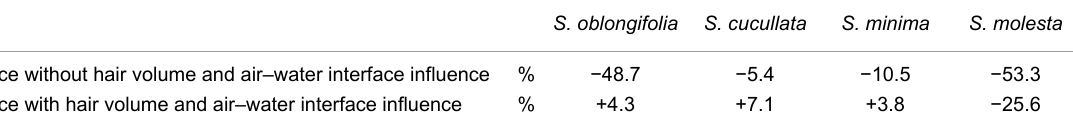
Table 4: Difference between the measured air volumes and the calculated theoretically maximum values in percent with and without the hair volumes and the shape of the air–water interface taken into